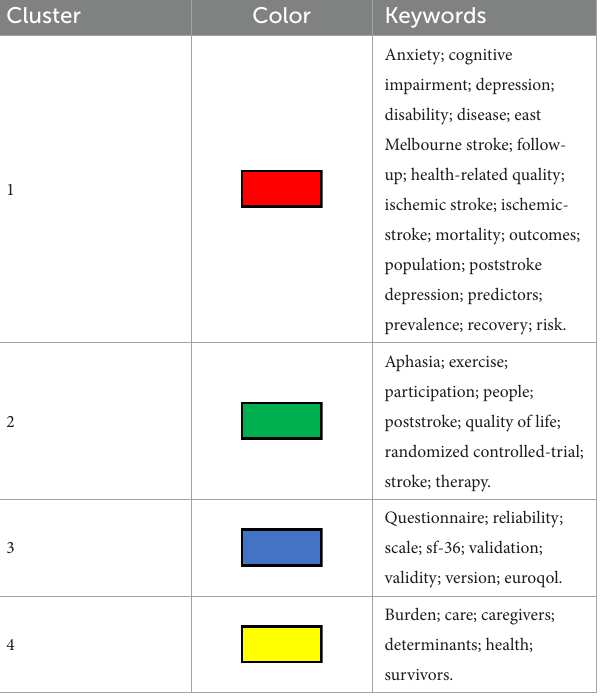
TABLE 5 Clusters of co-occurring keywords in areas.